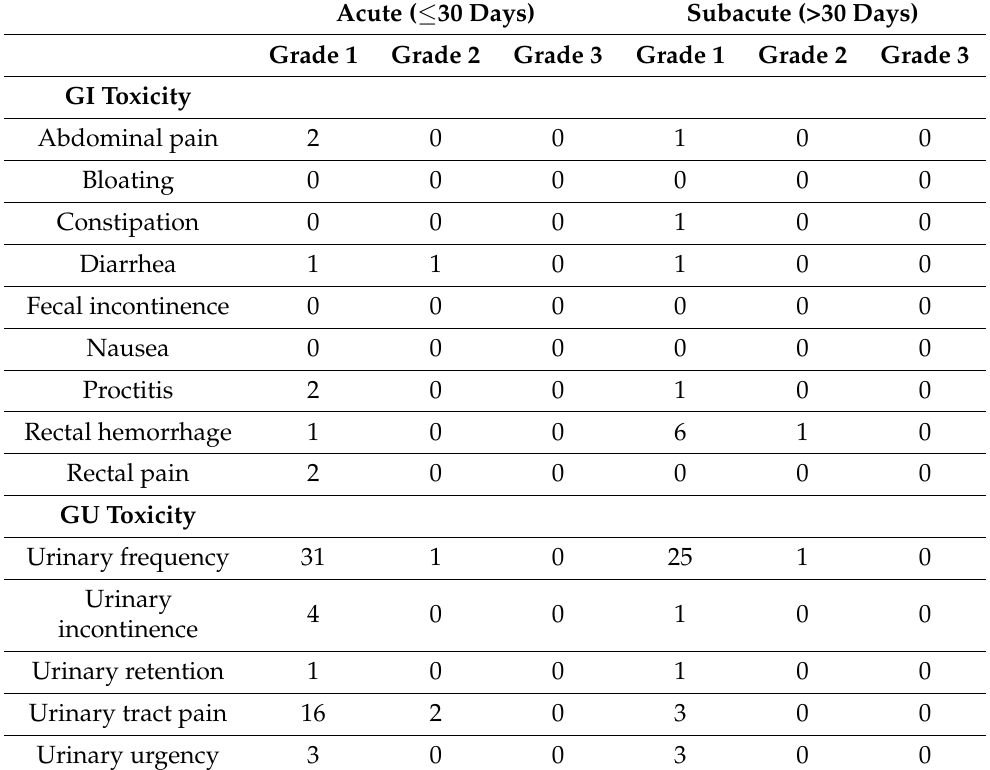
Table 3. The distribution of clinician reported gastrointestinal (GI) and genitourinary (GU) toxicities (grade ≥ 1) according to Common Terminology Criteria for Adverse Events (CTCAE) 5.0 in the patients ( N = 42).